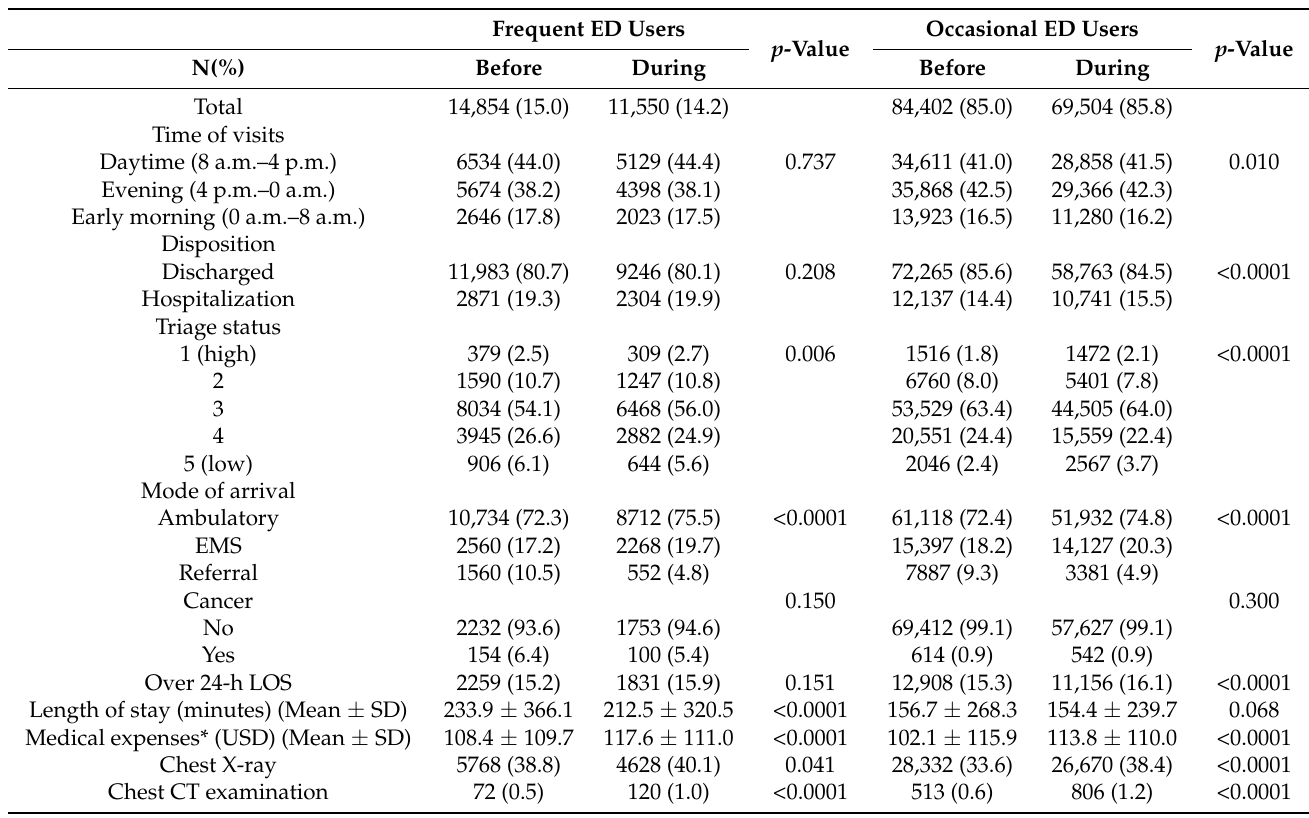
Figure 2. Trend of monthly emergency department visits before and during the COVID-19 pandemic. Table 2. Characteristics of ED visits before (February 2019–January 2020) and during the COVID-19 pandemic (February 2020 –January 2021) (n =